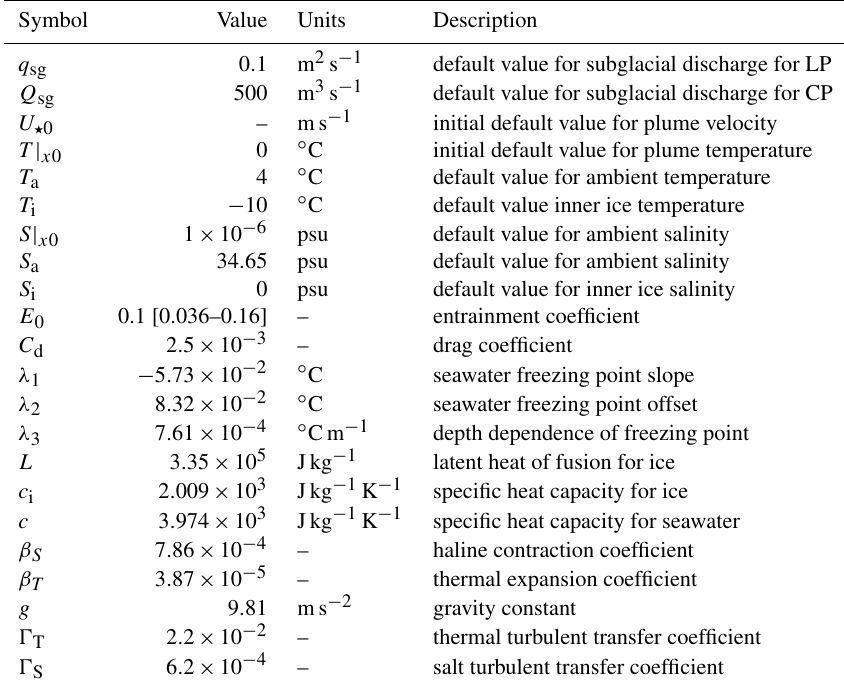
Table 1. Model parameters of the LP and CP model with typical fjord default values. Note that the values may differ for specific experiments (as explicitly stated in the corresponding descriptions). Symbol Value Units Description q sg 0 . 1 m 2 s − 1 default value for subglacial discharge for LP Q sg 500 m 3 s − 1 default value for subglacial discharge for CP U (cid:63) 0 – ms − 1 initial default value for plume velocity T | x 0 0 ◦ C initial default value for plume temperature T a 4 ◦ C default value for ambient temperature T i − 10 ◦ C default value inner ice temperature S | x 0 1 × 10 − 6 psu default value for ambient salinity 34 . 65 psu default value for ambient salinity psu default value for inner ice salinity 0.1 [0.036–0.16] – entrainment